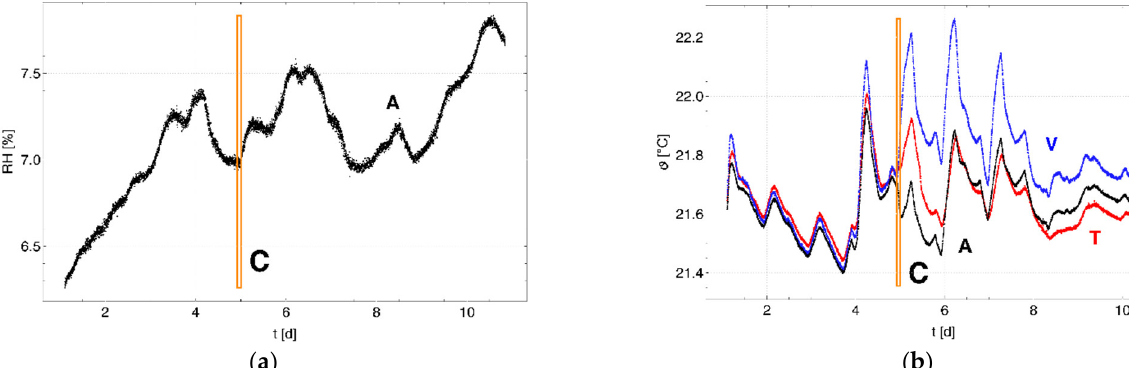
Figure A5. ( a ) Relative humidity in the air container and ( b ) temperatures in the containers (T: red, V: blue, A: black) of the test system. The orange box marked C indicates the change from Phase 1 to Phase 2.